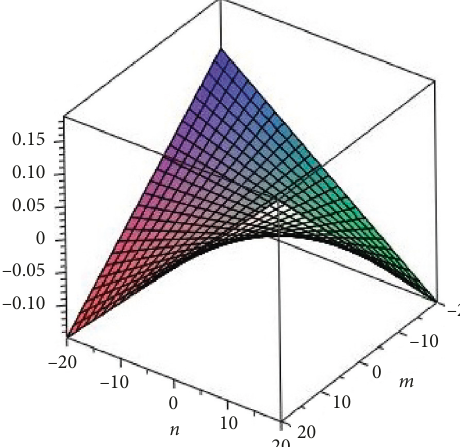
Figure 6: The 3D plot of the inverse Randi´c index for BR ( m,n )